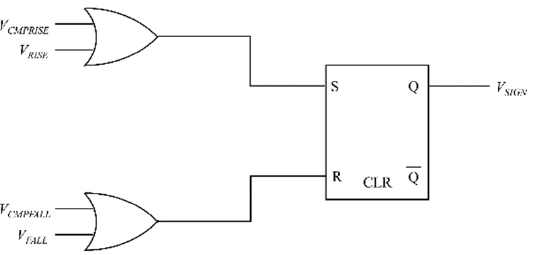
Figure 10. The schematic diagram of the compensation signal V SIGN generation circuit.